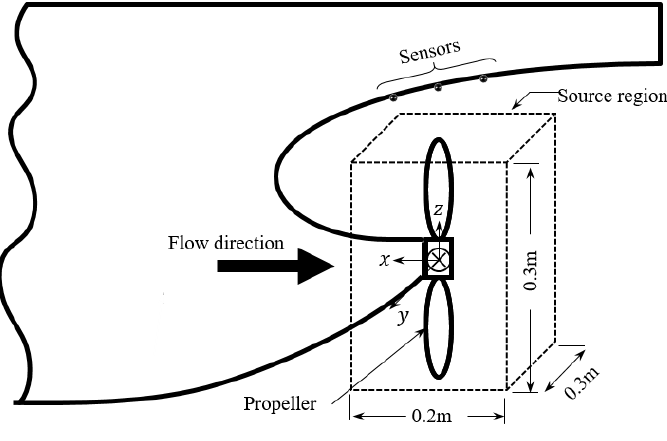
Figure 10. Assumed source